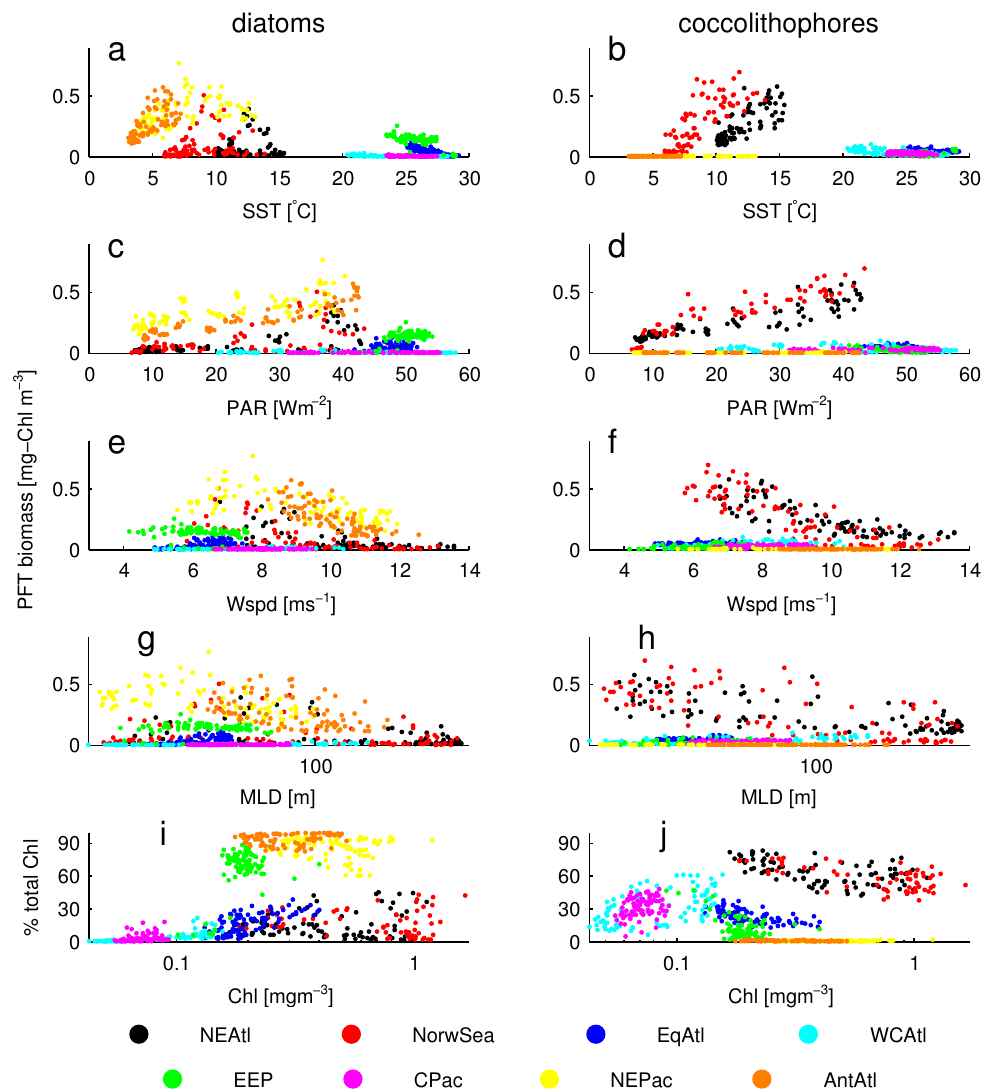
Fig. B1. Scatter plots showing the emerging relationship between NOBM diatom (left column) and coccolithophore (right column) biomass [mgChlm − 3 ] (a–h) or % of total Chl (i, j) vs. individual ecological indicators color coded according to domain of origin. On the x axis from top to bottom: SST, PAR, Wspd, MLD and Chl. All data points come from exploratory analysis only, and thus they are box average and monthly average estimates from October 1997 to December